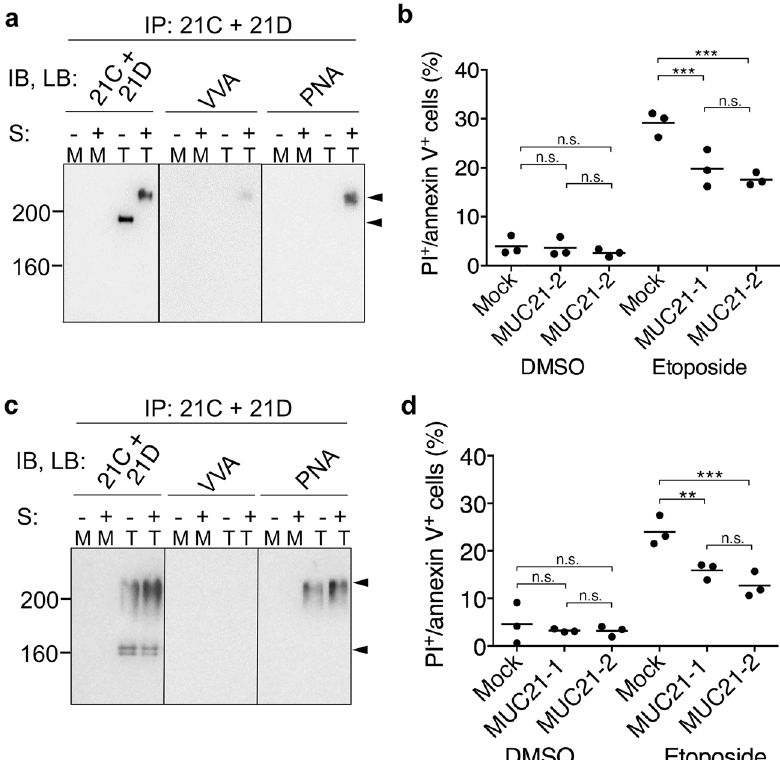
Fig. 5 Glycosylation and antiapoptotic effects of MUC21 expressed on CHO-K1 cells and CHO-Lec2 cells. a Electrophoretic and lectin- binding pro fi les of MUC21 expressed by CHO-K1 cells. The left panel shows the pro fi les of MUC21 before and after the cell lysates were treated with sialidase (S − or S + ), electrophoretically separated, and detected with a 1:1 mixture of mAbs heM21C (21C) and heM21D (21D). The middle panel indicates the pro fi le of MUC21 immunoprecipitated with a mixture of mAbs heM21C and heM21D, electrophoretically separated, blotted, and stained with biotinylated VVA. The right panel shows the result of a similar experiment but stained with PNA instead of VVA. The arrowheads tentatively indicate the position of sialidase-treated (top) and -untreated (bottom) sialyl T-MUC21. M; mock-transfected cell clone, T; MUC21-transfected cell clone. b Percentage of apoptotic cells among mock-transfectant cells and two clones of CHO-K1 cells transfected with full-length MUC21 (MUC21-1, MUC21-2) after treatment with 250 μ M etoposide for 48 h as determined by propidium iodide (PI) staining and binding of annexin V. Three independent experiments are shown. The mean is indicated as a horizontal line. Two-way ANOVA with Tukey ’ s multiple-comparison test. c Electrophoretic and lectin-binding pro fi les of MUC21 expressed by CHO-Lec2 cells. In all panels, S − and S + show the pro fi les of MUC21 before (S − ) and after (S + ) the cell lysates were treated with sialidase. In all panels, MUC21 was immunoprecipitated with a 1:1 mixture of mAbs heM21C (21C) and heM21D (21D), electrophoretically separated, and blotted. In the left panel, the blotted membrane was stained with a 1:1 mixture of mAbs heM21C and heM21D. In the middle panel, the membrane was reacted with biotinylated VVA. In the right panel, biotinylated PNA was used. The arrowheads tentatively indicate the position of nonsialylated T-MUC21 (top) and nonglycosylated MUC21 (bottom). M; mock-transfected cell clone, T; MUC21-transfected cell clone. ( d ) Percentage of apoptotic CHO-Lec2 cells transfected with full-length MUC21 (clone MUC21-1 and MUC21-2) or mock transfectant after treatment with 250 μ M etoposide for 31 h as determined by PI staining and binding of annexin V. Three independent experiments are shown. The mean is indicated as a horizontal line. Two-way ANOVA with Tukey ’ s multiple-comparison test. ** p < 0.01, *** p < 0.001, n.s. not signi fi cant, IP immunoprecipita- tion, IB immunoblot, LB lectin blot, PNA peanut (Arachis hypogaea) agglutinin, VVA: Vicia villosa tandem-repeat domain ( Δ -TR) or MUC21 with a deleted cytoplasmic domain ( Δ -CT), speci fi c forward primers and reverse primers were used to amplify the truncated region. The primers used for 3 x FLAG-MUC21- Δ -TR were MUC21- Δ -TR-Forward; 5 ′ CGCCGTCTCTTCTGCAGGCTCTGGAACA3 ′ ;